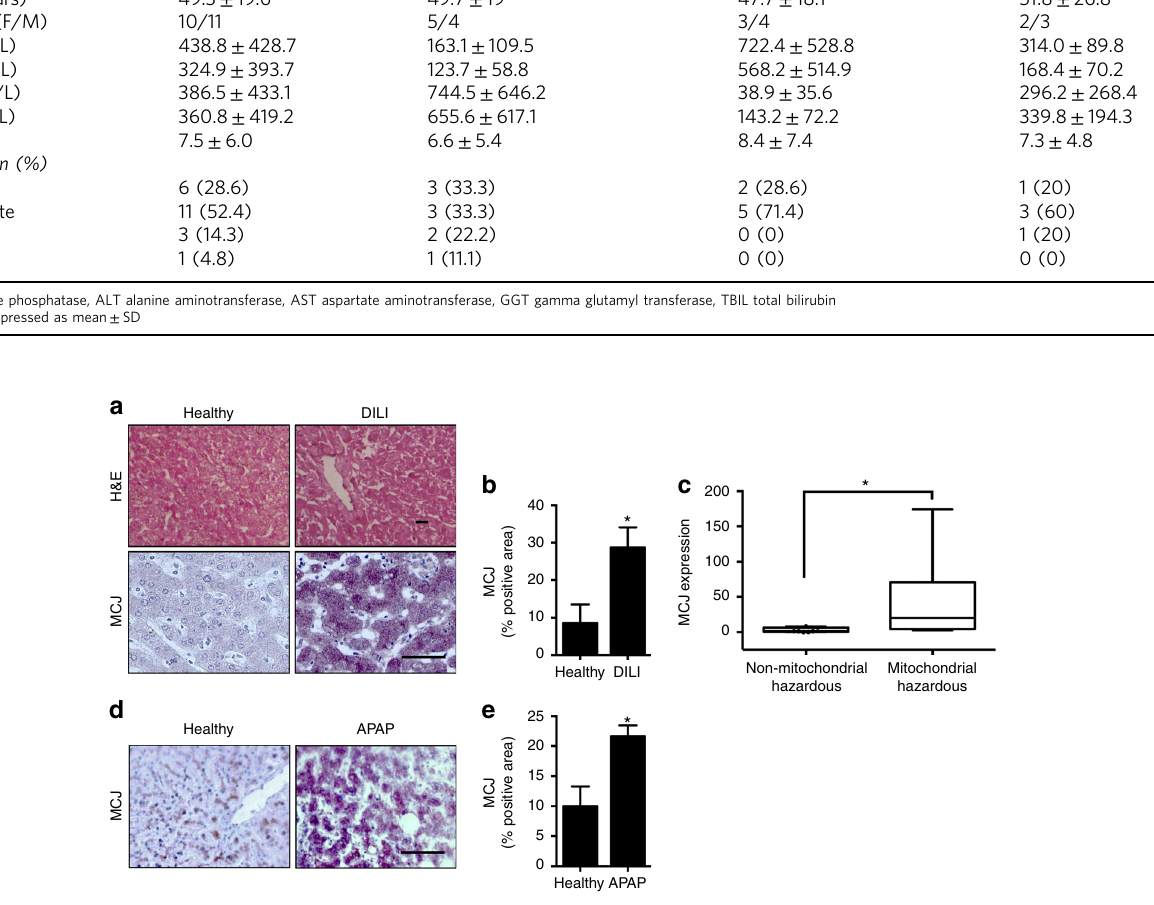
Fig. 6 MCJ expression is increased in human DILI. a – c Human samples from healthy control subjects (Healthy) ( n = 7) and from patients with drug-induced liver injury (DILI) ( n = 21). a MCJ expression in liver was determined by immunohistochemistry and b quanti fi ed. c Correlation between MCJ expression and drug grade of mitochondrial liability in DILI patients. d , e Human samples from healthy control subjects (Healthy) ( n = 7) and from patients with acetaminophen-induced liver injury (APAP) ( n = 24). a MCJ expression in liver was determined by immunohistochemistry and b quanti fi ed. Scale bar corresponds to 100 μ m. Values are represented as mean ± SEM. * P < 0.05 (Student ’ s t test) (DILI vs. Healthy, mitochondrial hazardous vs. non- mitochondrial hazardous, and APAP vs.